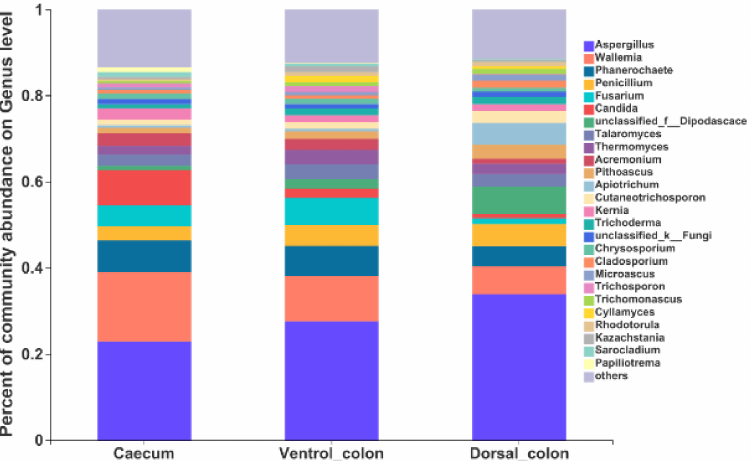
Figure 5. Composition of the fungal genera (relative abundance >1%) among donkey caecum, ventral colon, and dorsal colon ( n = 8).